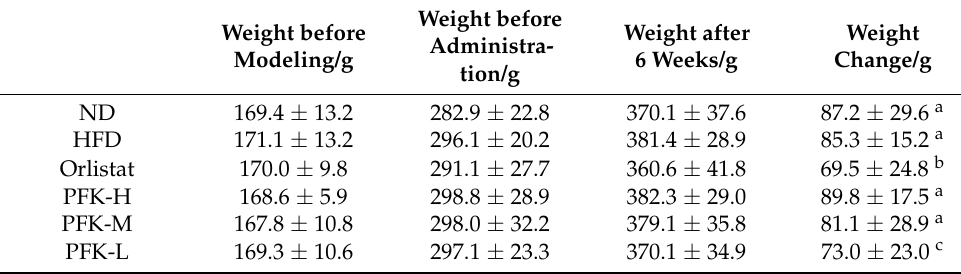
Table 1. Effects of PFK complex on body